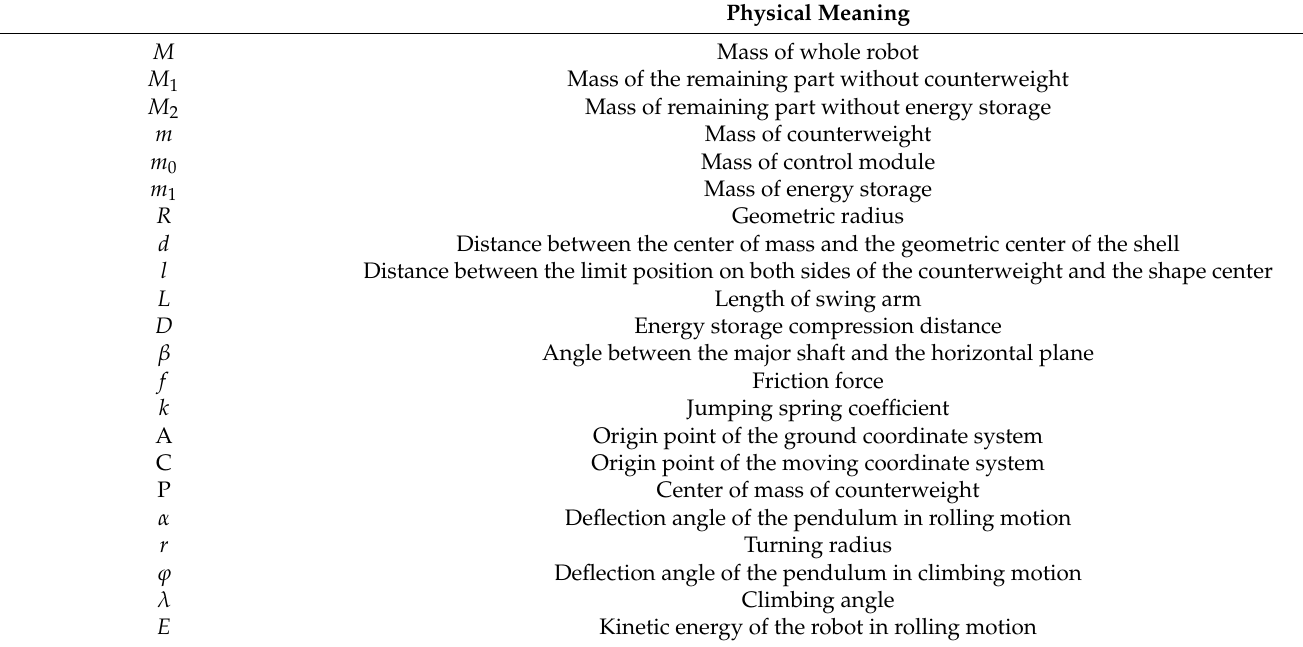
Table 1. Parameters of the robot.